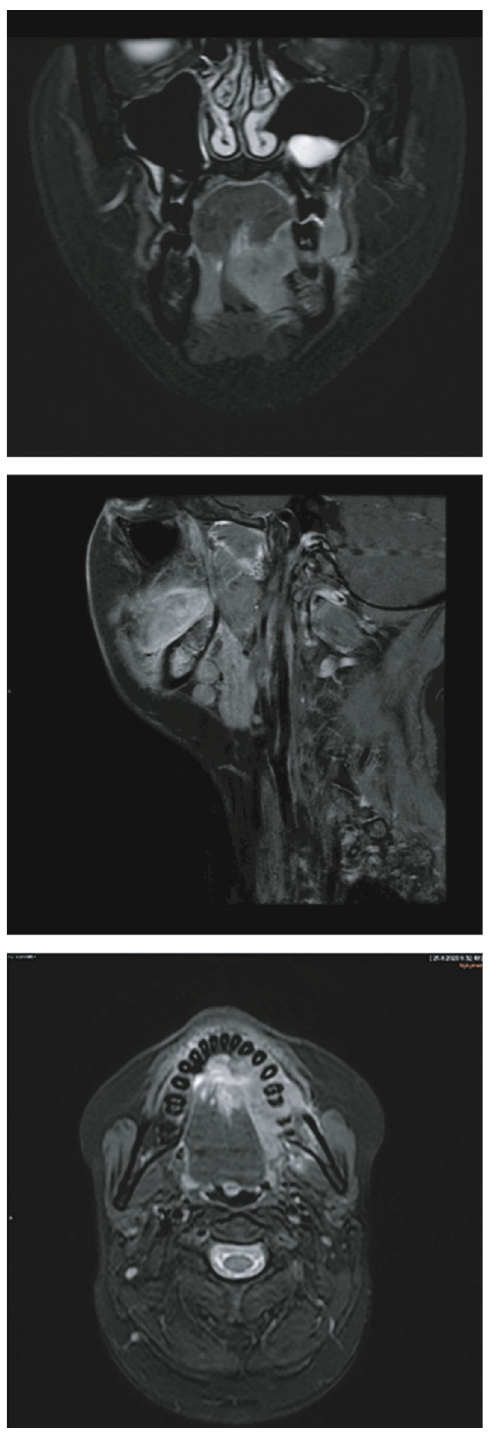
Figure 2: Contrast-enhanced MRI taken after initial examination. The tumor mass is shown in fi ltrating the mandibular bone, intrinsic musculature of the tongue, and the buccal mucosa, up to the depth of the mylohyoid muscle on the left side. Submandibular pathologic lymph node enlargement is also